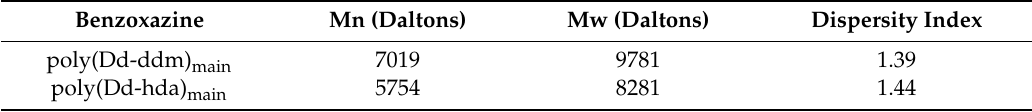
Table 1. Molecular weight of poly(Dd-ddm) main and poly(Dd-hda) main .